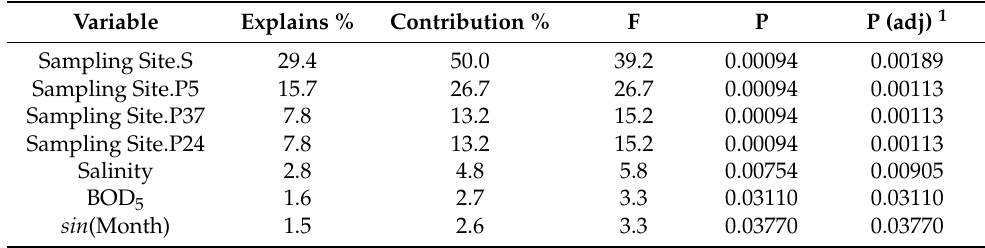
Table 1. Descriptive statistics of RDA analysis on samples collected along the salinity